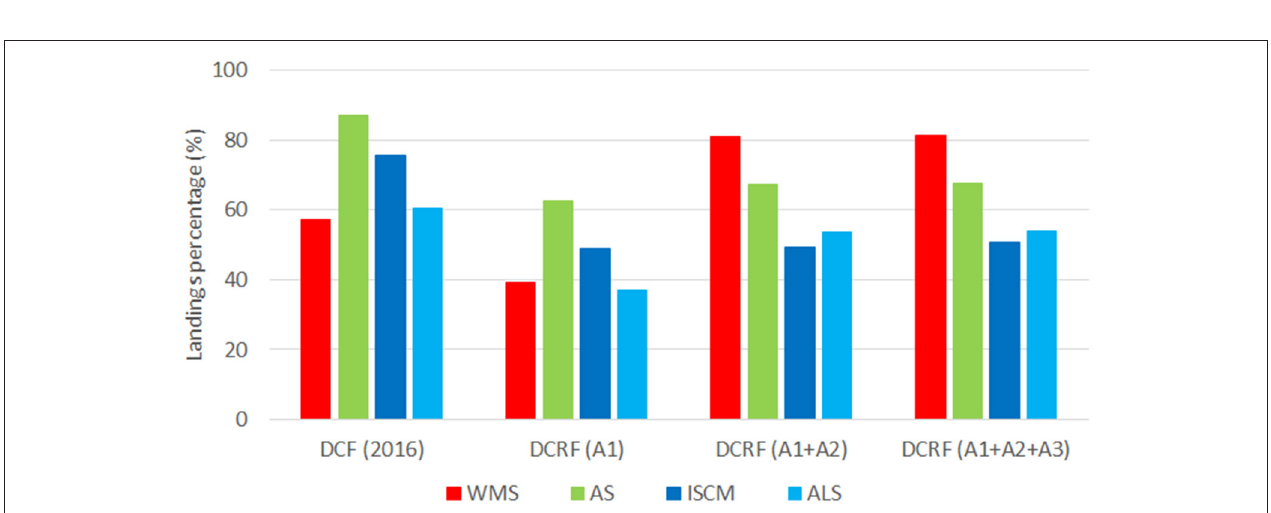
FIGURE 6 | Percentage of landings whose data collection is required under recently reviewed international obligations. Estimates are given at MSFD subregional level. WMS, Western Mediterranean Sea; AS, Adriatic Sea; ISCM, Ionian Sea and Central Mediterranean; ALS, Aegean-Levantine Sea. DCF (2016): percentage of landings corresponding to stocks’ list object of the recent revision of DCF (EU-COM, 2016). DCRF: Percentage of landings corresponding to stocks’ list object of the recent revision of the GFCM Data Collection Regional Framework (FAO, 2016). A1: Stocks that drive the fishery and for which assessment is regularly carried out; A2: Stocks which are important in terms of landing and/or economic values at regional and subregional level, and for which assessment is not regularly carried out; A3: Species within international/national management plans and recovery and/or conservation action plans; non-indigenous species with the greatest potential impact.